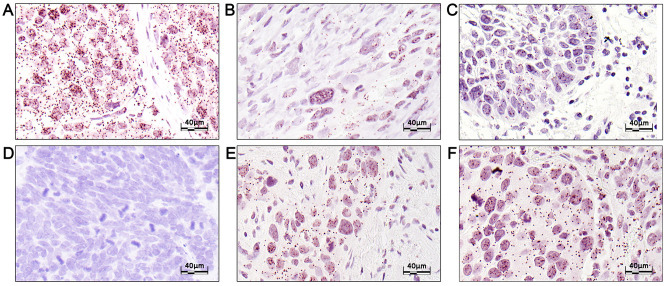
In situ PLA showing IGF1R/PCNA colocalization in cancer tissue.Representative photomicrographs of IGF1R/PCNA in situ proximity ligation assay (PLA) in different cancer forms. A) desmoplastic melanoma, B) malignant peripheral nerve sheath tumor, C) oropharyngeal squamous cell carcinoma, D) Merkel cell carcinoma, E) high-grade urothelial carcinoma, F) pulmonary adenocarcinoma. Strong nuclear and cytoplasmic colocalization was found in a desmoplastic melanoma (A). Sometimes, we observed more PLA signals in dysplastic cells, here represented by a malignant peripheral nerve sheath tumor (MPNST)/sarcoma (B). Varying levels of IGF1R/PCNA colocalization were found depending on the type of tumor, but it was frequently stronger in tumor cells than surrounding tumor stroma (E) or tumor infiltrating lymphocytes (C). Some cases showed no signals in the tumor cells, here represented by a Merkel cell carcinoma (D).